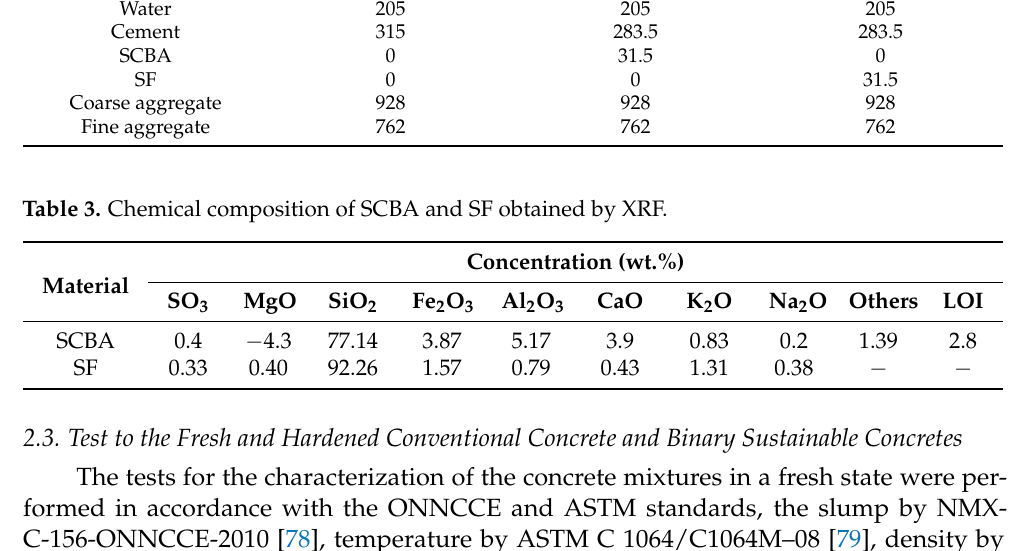
Table 3. Chemical composition of SCBA and SF obtained by XRF.